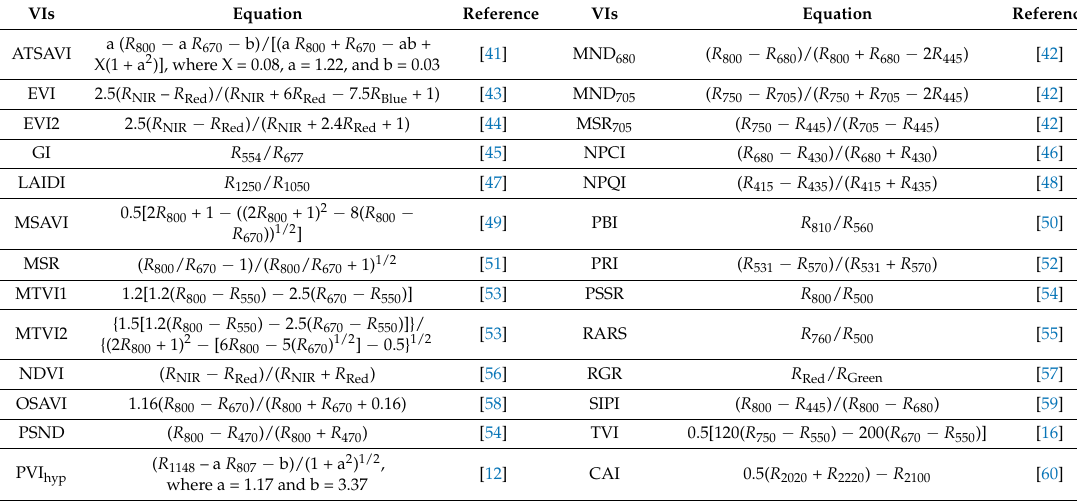
Table 2. Summary of VIs used in this